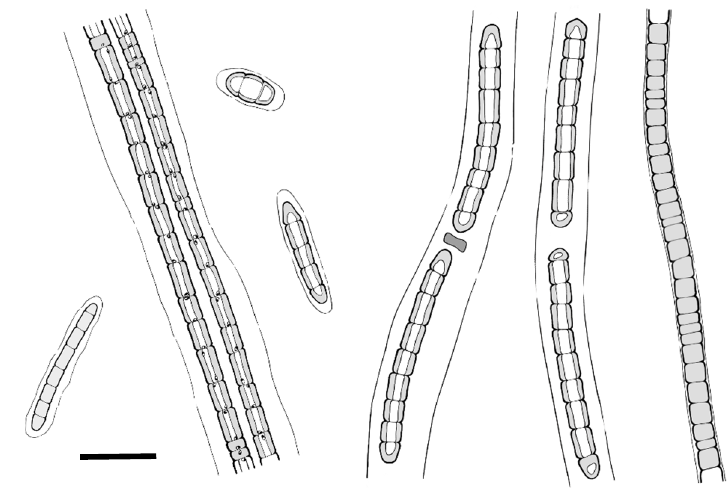
Figure 2. Line drawings of Stenomitos nagquensis sp. nov; scale bar = 5 µ m. Description: Colonies were thin, flat, and blue–green, slowly spreading on the surface of solid BG11 medium. Filaments were thin, occasionally coiled, and sometimes appearing loosely parallel or spirally arranged. Two overlapping trichomes in one firm sheath were rarely observed, with false or true branching absent. Trichomes were isopolar, untapered, and clearly constricted at the cross-walls. Mucilaginous sheaths were colorless, firm, hyaline, persistent, and widened in the younger stages, while they were thin in older colonies. Vegetative cells were bright blue–green in younger colonies, green in older stages, isodiametric to slightly longer than wide in younger cells, and wider than long when compressed, particularly in the older stages, reproducing through simple binary fission in a single plane. Polar granules were evident in some vegetative cells, mostly granulated in older stages. Vegetative cells were 0.4–2.2 µ m long and 0.5–1.2 µ m wide. Apical cells were rounded to slightly conical, rarely elongated, and similar in size with most vegetative cells. Hormogonia were motile and usually composed of 3–10 cells. Thylakoids were parietal. Necridia were